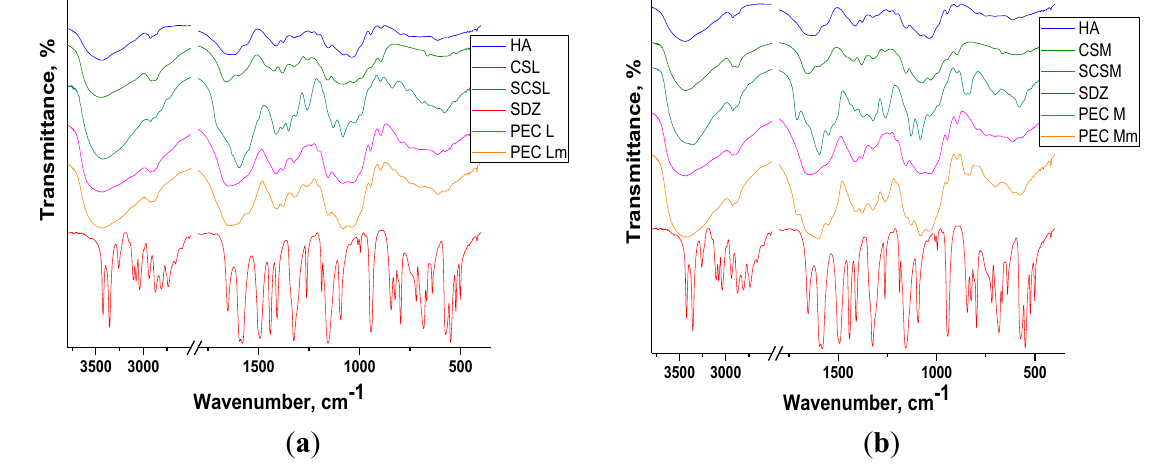
Figure 3. FT-IR spectra of components and of PEC sponges based on ( a ) CSL/SCSL and ( b ) CSM/SCSM (PEG: polyelectrolyte complexes, CSL/SCSL: chitosan low molecular